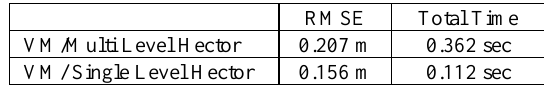
Figure 13. VM- Single-Level Hector SLAM Performance (Second Experiment).